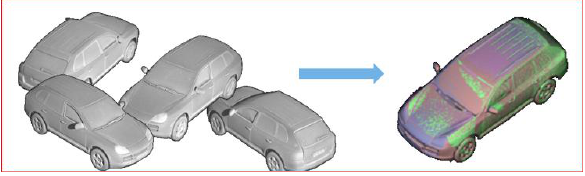
Figure 15: Direct alignment of scans